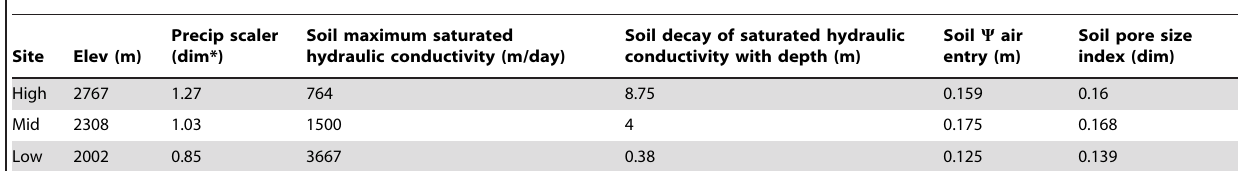
Table 1. Site characteristics and soil parameters.